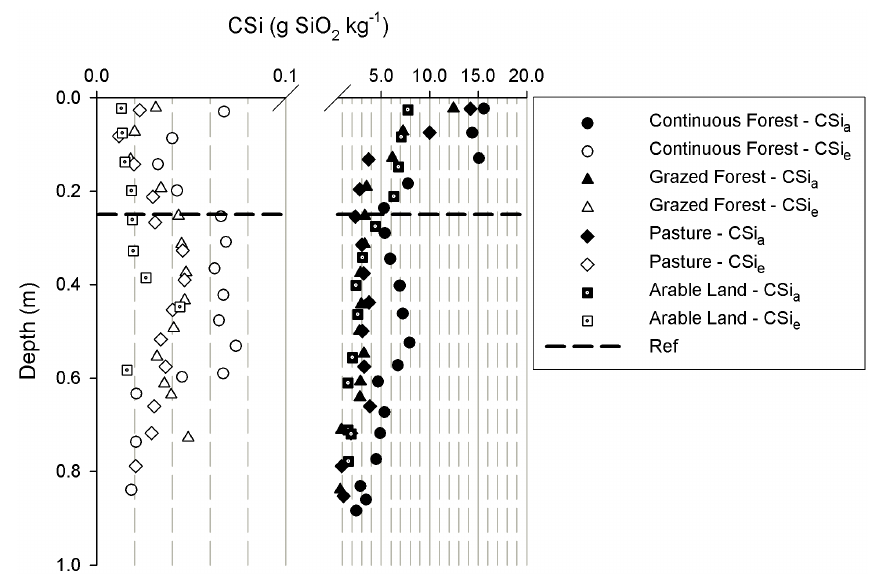
Fig. 4. Average distribution of alkaline extracted silica (CSi a , solid black) and easily soluble silica (CSi e , open) in gSiO 2 kg − 1 dry soil in soils under various land uses in southern